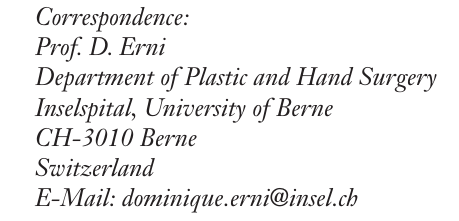
Figure 2 Delayed recon- struction (above). Sixty-seven year old patient 12 months after delayed breast reconstruction with free TRAM flap and contralateral breast reduction, and 8 months after NAC reconstruction with nipple-share from the healthy side and tat- tooing of the areola. Immediate recon- struction (below). Sixty-four year old patient 13 months after skin sparing mastectomy and im- mediate breast recon- struction with TRAM flap, nipple recon- struction with reim- plantation of the orig- inal nipple and areola tattooing. Skin spar- ing mastectomy maintains the natural shape, texture and colour of the breast and provides incon- spicuous scars placed in the natural aesthetic borderline defining the circum- ference of the areola. The scar at the ab- dominal donor site is hidden by the under- wear in both